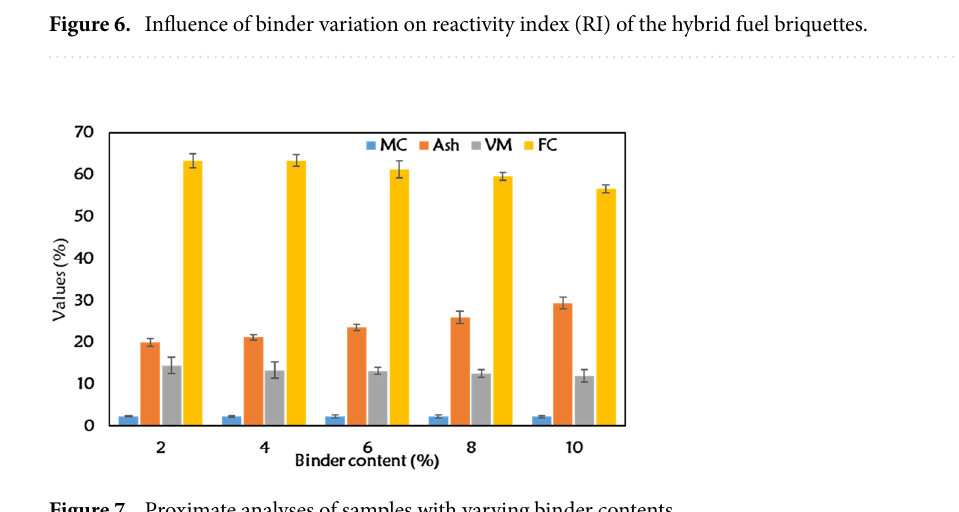
Figure 7. Proximate analyses of samples with varying binder